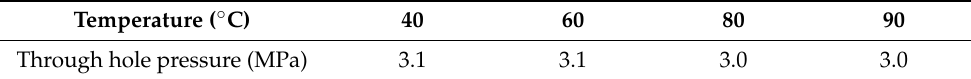
Table 8. Experimental data on thermal stability of particles at different temperatures.